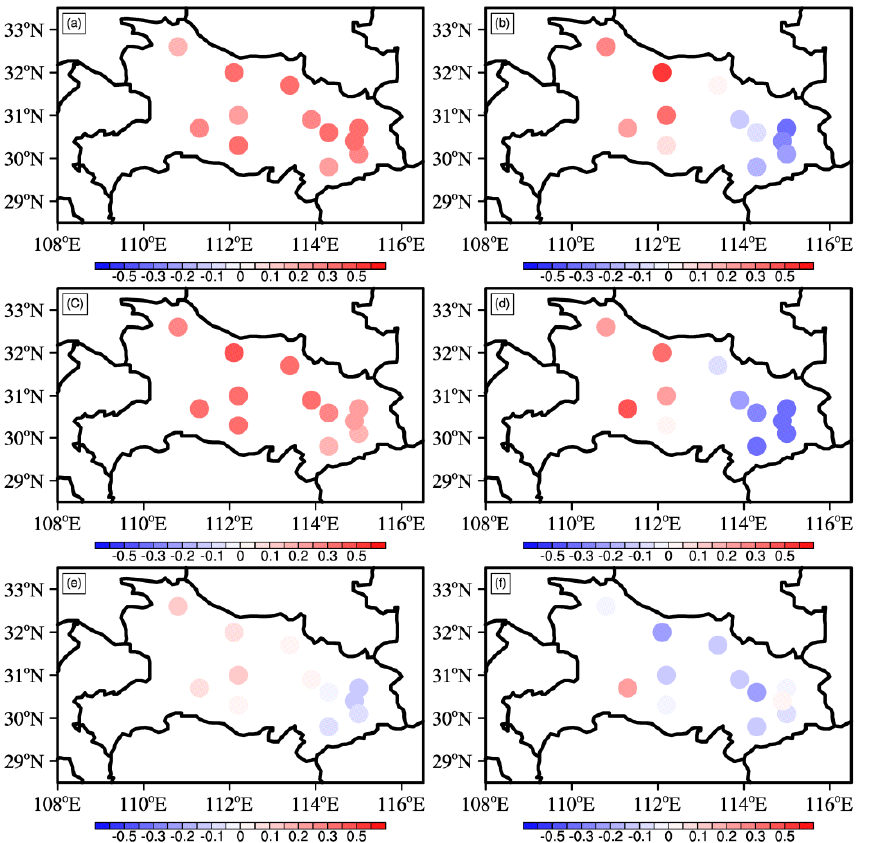
Figure 4. Spatial distribution of eigenvectors of PM 2.5 mass concentration EOF decomposition in Hubei Province. ( a ) Average of 2016–2019 EOF1, ( b ) average of 2016–2019 EOF2, ( c ) 2020 EOF1, ( d ) 2020 EOF2, ( e ) difference between 2020 and 2016–2019 EOF1, and ( f ) difference between 2020 and 2016–2019 EOF2.